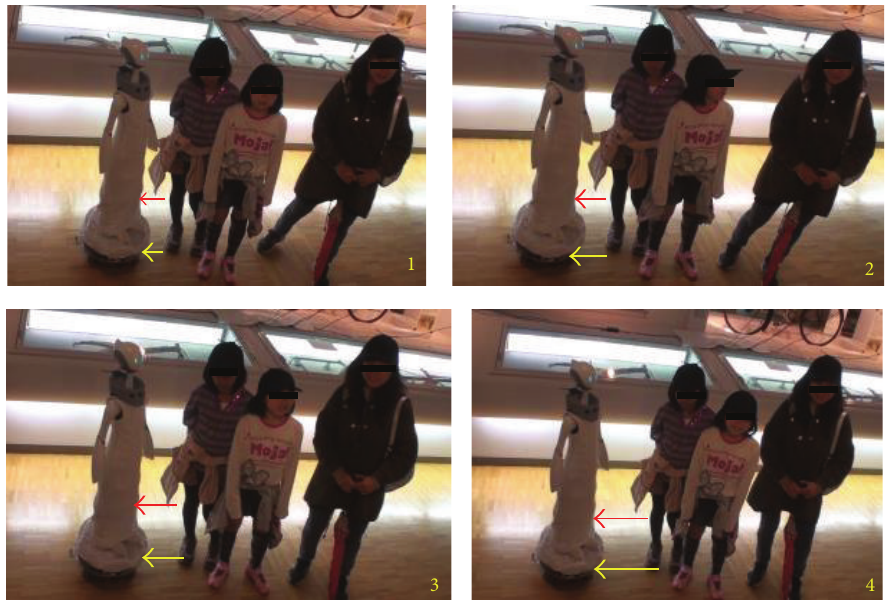
Figure 5: The lean back